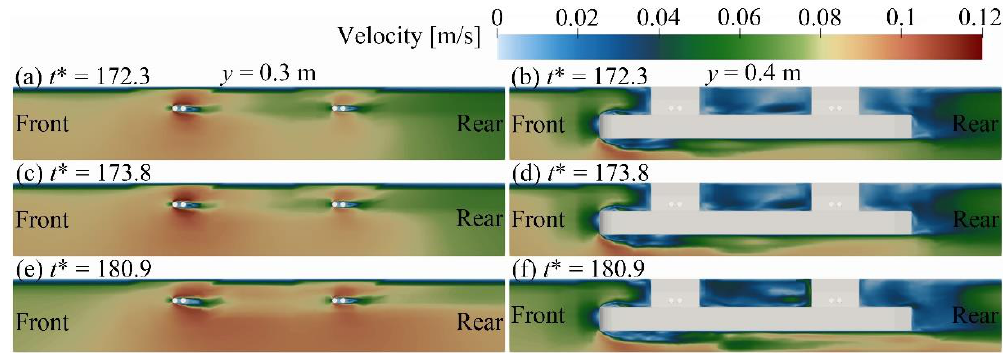
Figure A3. Velocity around the platform at y = 0.3 m and y = 0.4 m for Case A2.